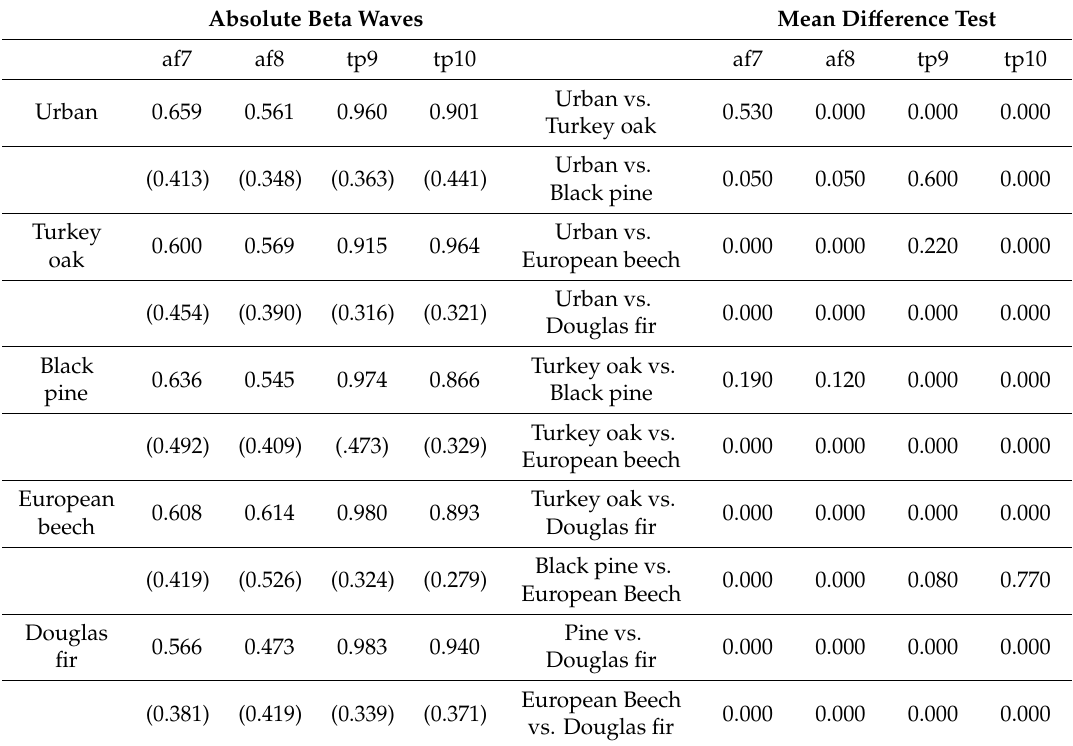
Table 1. Mean values of beta waves and p -values of mean di ff erence